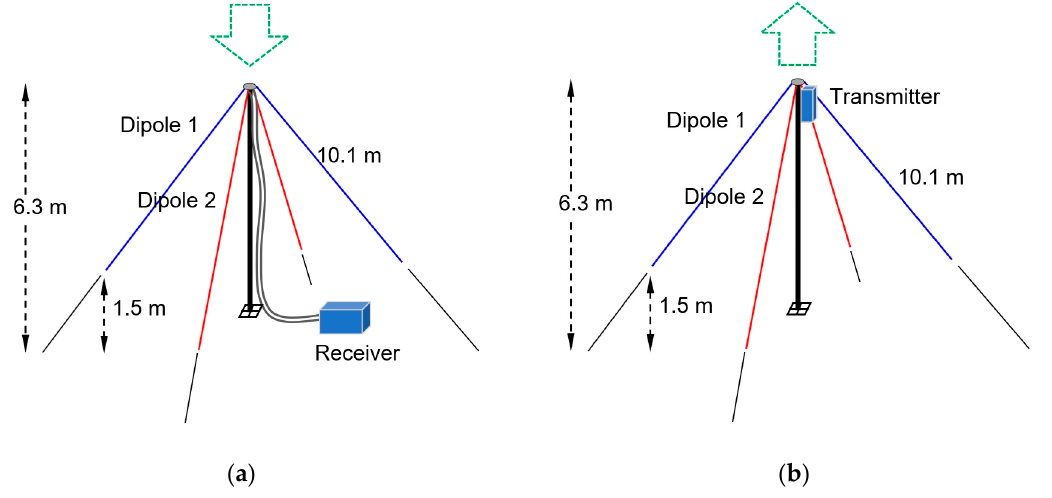
Figure 5. ( a ) The sensor; ( b ) One of the probes. Distance between probe and sensor is 50–200